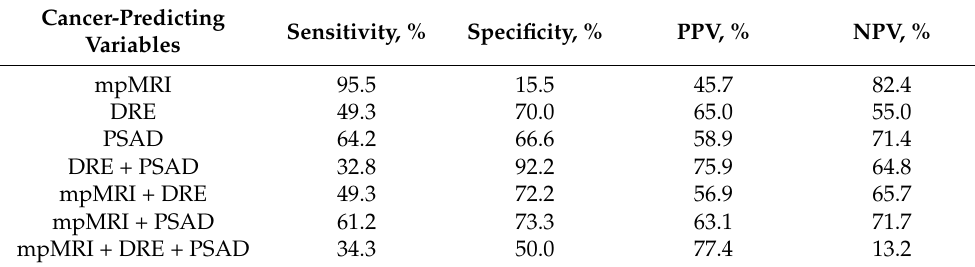
Table 3. Sensitivity and specificity for clinically significant prostate cancer (ISUP ≥ 2); mpMRI was